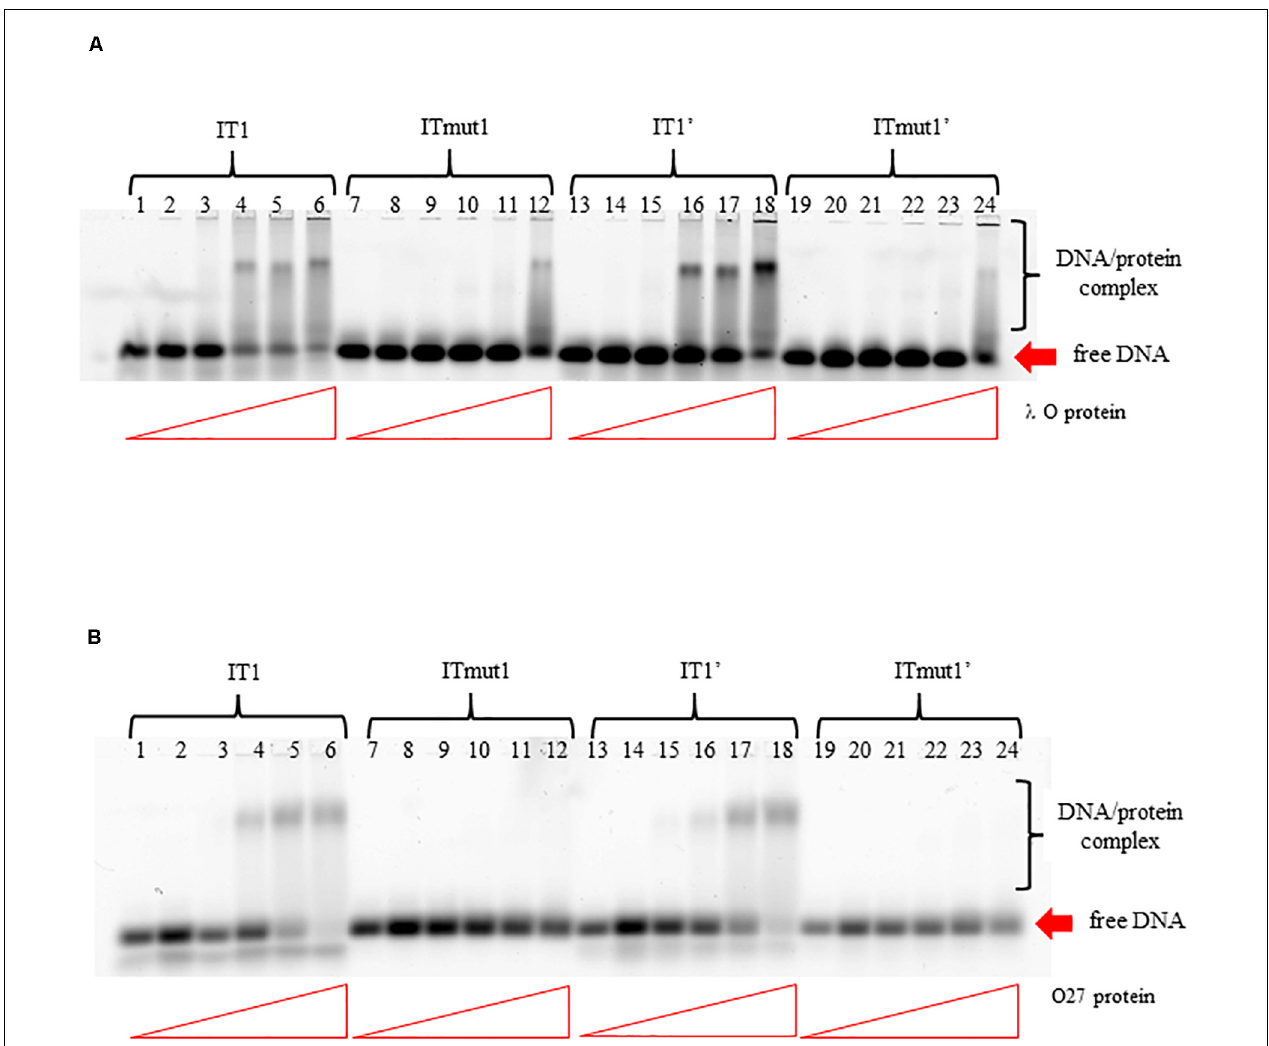
FIGURE 6 | Interactions of O proteins of phages λ panel (A) and P27 panel (B) with DNA templates containing various versions of iterons (IT), as assessed by EMSA. Templates with wild-type iterons 1 or 1 (cid:48) (IT1 or IT1 (cid:48) , respectively) and with mutant iterons 1 or 1 (cid:48) , unable to bind O proteins (ITmut1 or ITmut1 (cid:48) , respectively) were used. Increasing molar ratios of DNA:O proteins, indicated in particular wells, were as follows: 1:2, 1:4, 1:8, 1:16, and 1:32. Lanes no. 1, 7, 13, and 19 contain no O